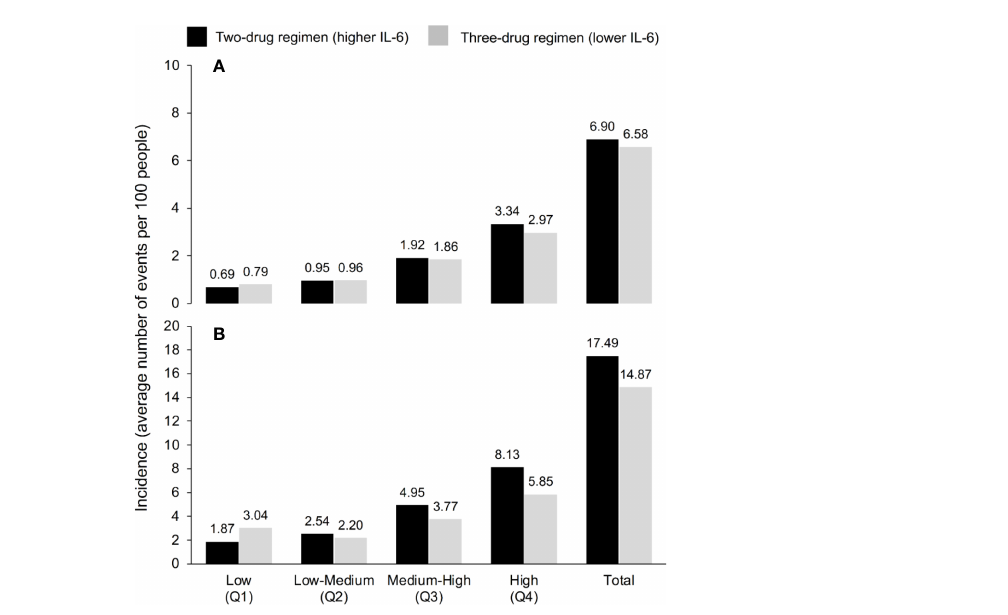
FIGURE 2 Incidence of serious non-AIDS events (cardiovascular, hepatic or renal event, or malignancy) or all-cause death according to IL-6 quartile and ART regimen over (A) 3 years and (B) 5 years, according to the model, which used the IL-6 trajectories seen in TANGO (n=741, up to Week 144) and AIR (n=148, Weeks 144 –